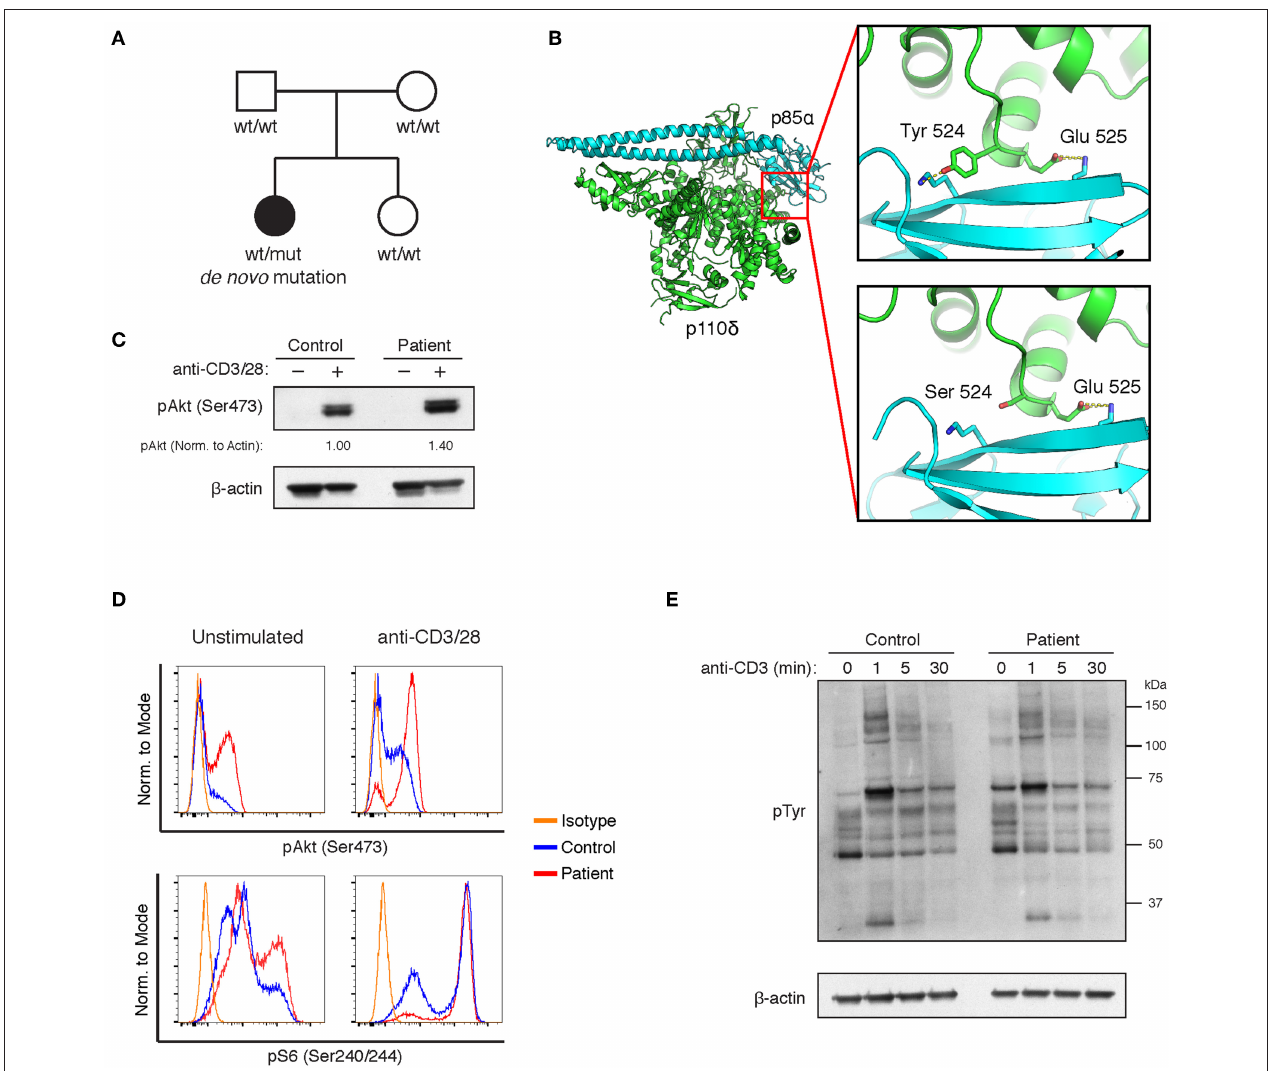
FIGURE 1 | A novel Y524S variant in p110 δ causes APDS. (A) Pedigree showing a de novo variant in p110 δ . (B) Molecular model showing the location of the Y524S variant in relation to p85 α . Note the loss of the hydrogen bond and buried surface area when Tyr 524 is mutated to Ser. (C) Levels of phospho-Akt (Ser473) and β -Actin in CD4 cells purified from control or patient PBMCs were assayed by Western blotting. Cells were unstimulated ( − ) or stimulated with anti-CD3 and anti-CD28 for 5 min ( + ). Results are representative of three experiments. (D) Flow cytometry of control or patient CD4 + PHA blasts. Cells were assayed for phospho-Akt (Ser473) and phospho-S6 (Ser240/244) with or without stimulation for 10 min with anti-CD3 and anti-CD28. Results are representative of two experiments. (E) Western blotting for phosphotyrosine in freshly purified control or patient CD4 + T cells, either unstimulated or stimulated for the indicated times with